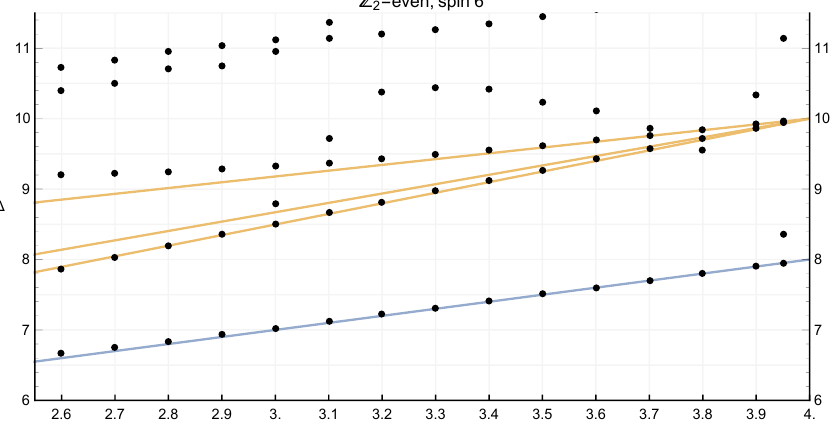
Figure 7 . Z 2 -even operators of spin 6.